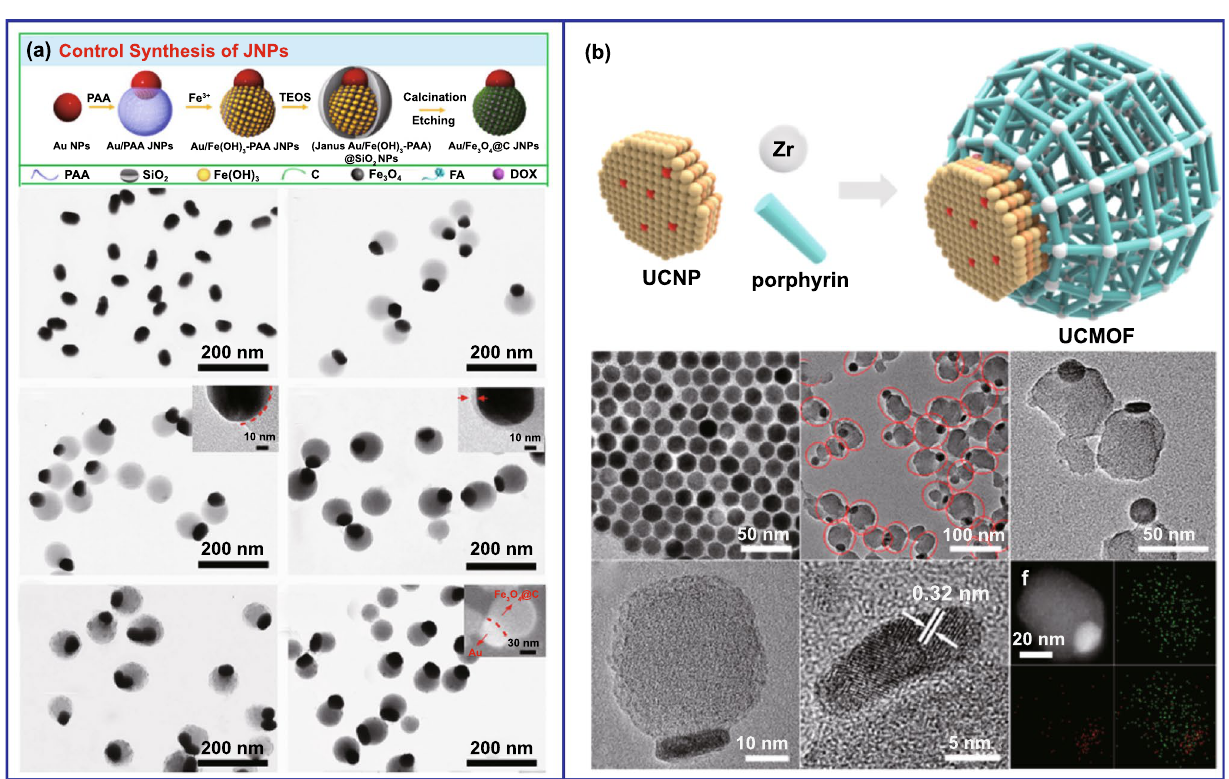
Fig. 5 Preparation of various asymmetric polymer- and MOF-based nanoparticles. a Preparation of Au/Fe 3 O 4 @C Janus nanoparticles by con- trolling the surface interfacial energy. Reproduced with permission from Ref. [51]. Copyright 2017, Wiley–VCH. b Fabrication of Janus struc- tured MOF-UCNPs by selectively modifying the surface. Reproduced with permission from Ref. [54]. Copyright 2017, American Chemical